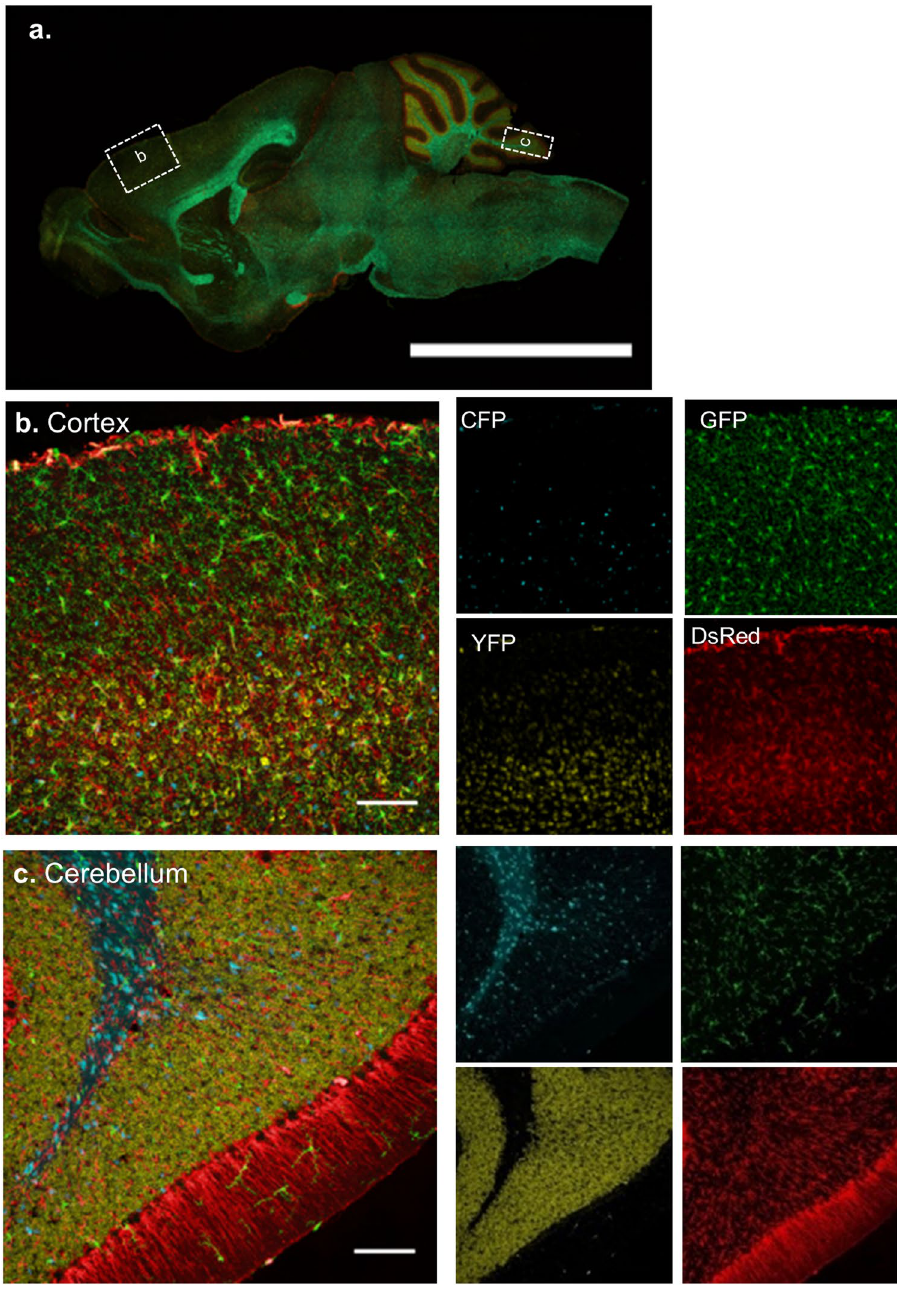
Figure 2. Expression of distinct fluorophores in CNS cells in different brain regions in a PrismPlus mouse line. ( a ) Epifluorescence image of a sagittal mouse brain section depicting approximate brain regions (dashed boxes) for images in b and c. CFP-expressing oligodendrocytes, GFP-expressing microglia, YFP-expressing neurons and DsRed-expressing astrocytes, and merged confocal images in cortex ( b ) and cerebellum ( c ) of a PrismPlus mouse. Single channel images of ( b ) and ( c ) are shown right to the merged images. Images are maximum projected intensity of 20 um thick section. Scale bar in a = 5 mm; b & c = 100 µ